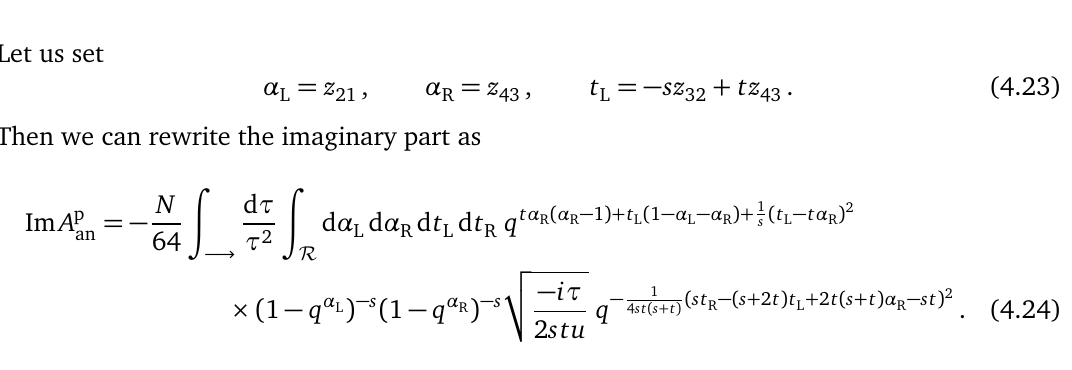
Figure 14: The region where Trop < 0 for the planar annulus. The figure is drawn for s = 1 and t = − 1 2